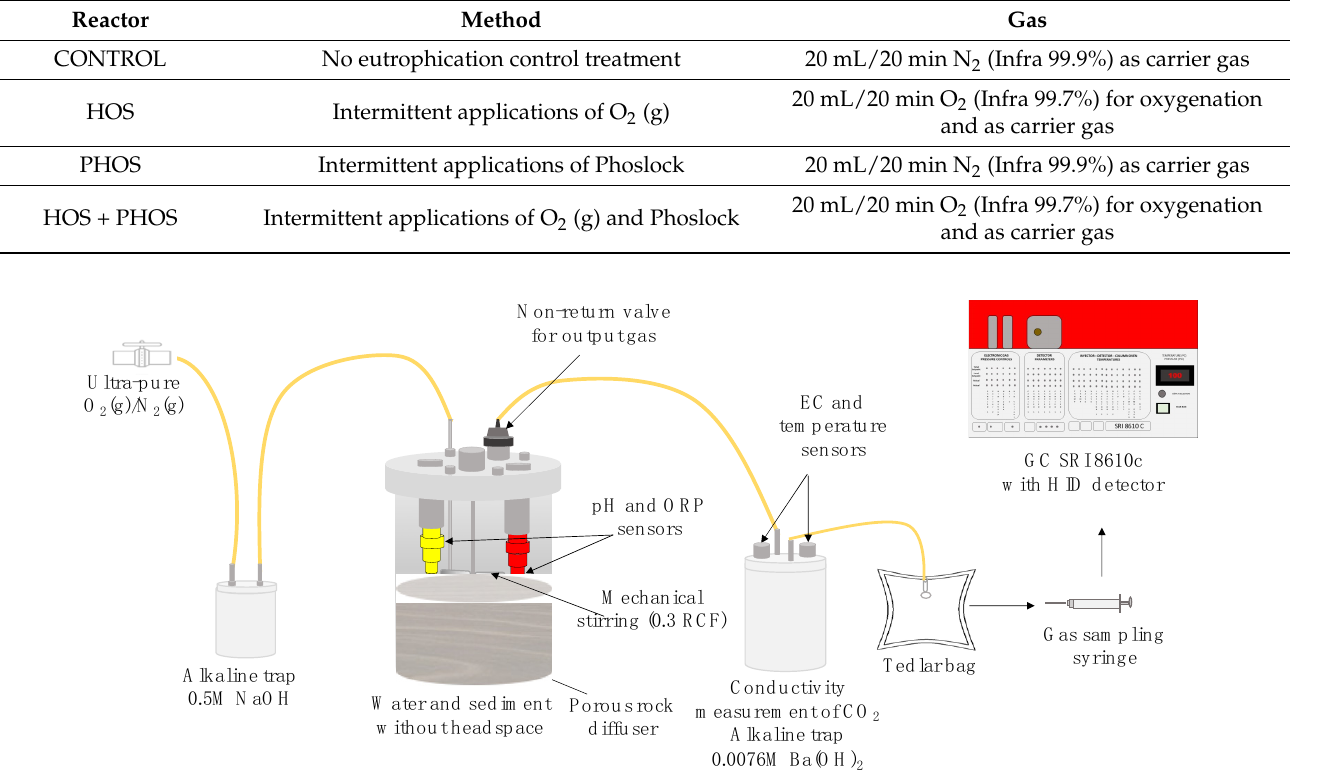
Figure 2. Experimental respiration and gas-trapping system.